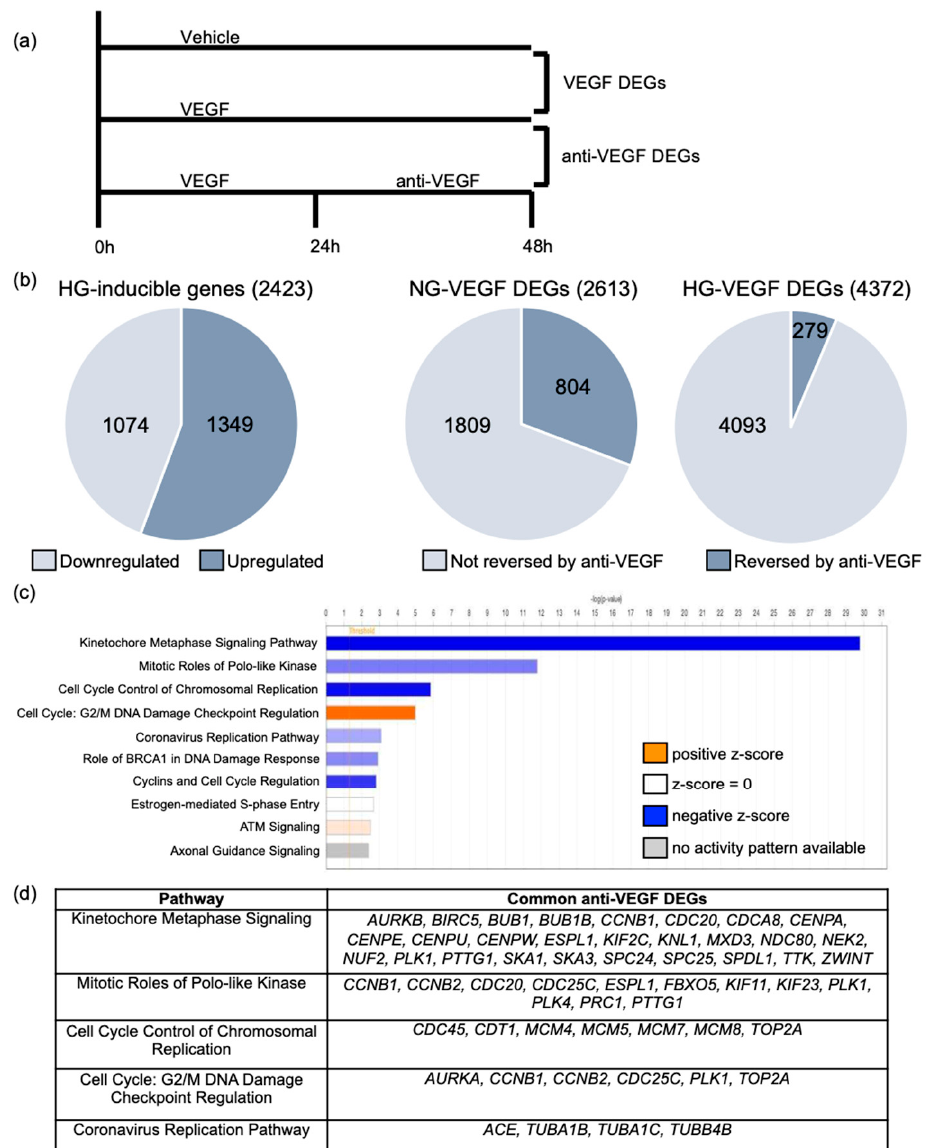
Figure 1. The glucose concentration changed both the number of genes that responded to VEGF and the percentage of them that were reversed by anti-VEGF. ( a ) Schematic depicting treatment conditions of normal-(NG) and high-glucose (HG) human retinal endothelial cells (HRECs) analyzed using RNA-Seq. HRECs were treated with vehicle (PBS), vascular endothelial growth factor (VEGF; 1 nM), or anti-VEGF (500 nM) for times listed. ( b ) Pie charts representing the number of genes differentially expressed in NG and HG HRECs in response to VEGF. VEGF DEGs were further organized by their responsiveness to anti-VEGF. ( c ) List of the top 10 pathways regulated by VEGF/anti-VEGF in NG and HG HRECs, as determined by ingenuity pathway analysis. Pathways were sorted by statistical significance. ( d ) Chart showing the genes associated with the five top pathways regulated by VEGF/anti-VEGF in both glucose concentrations.